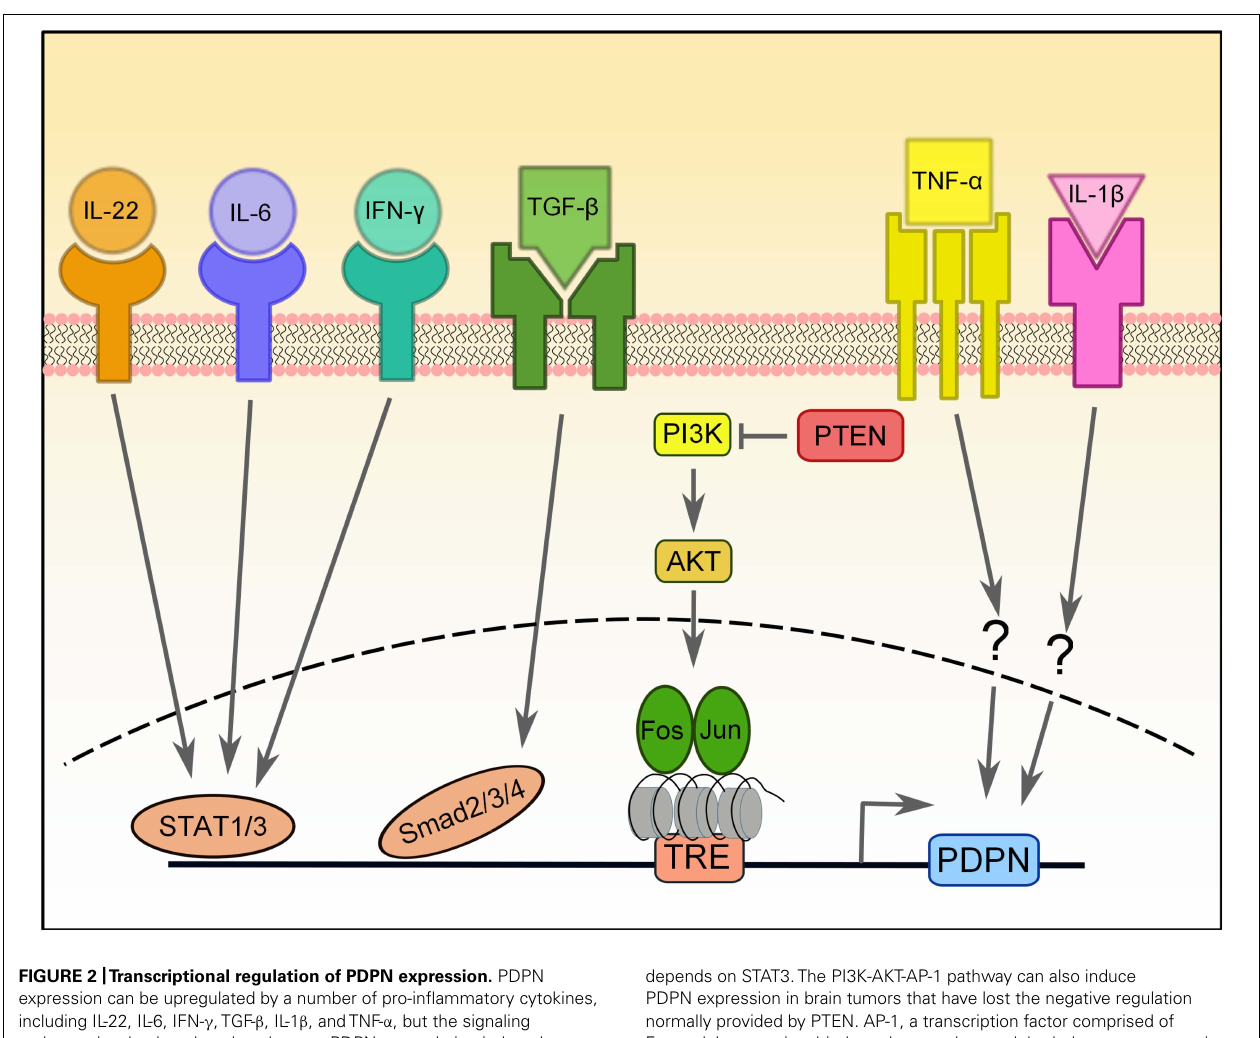
FIGURE 2 |Transcriptional regulation of PDPN expression. PDPN expression can be upregulated by a number of pro-inflammatory cytokines, including IL-22, IL-6, IFN- γ ,TGF- β , IL-1 β , andTNF- α , but the signaling pathways involved are largely unknown. PDPN upregulation induced byTGF- β requires Smad2/3 and 4 activity, while upregulation induced by IFN- ψ depends on STAT1 and STAT3 and that of IL-6 and IL-22